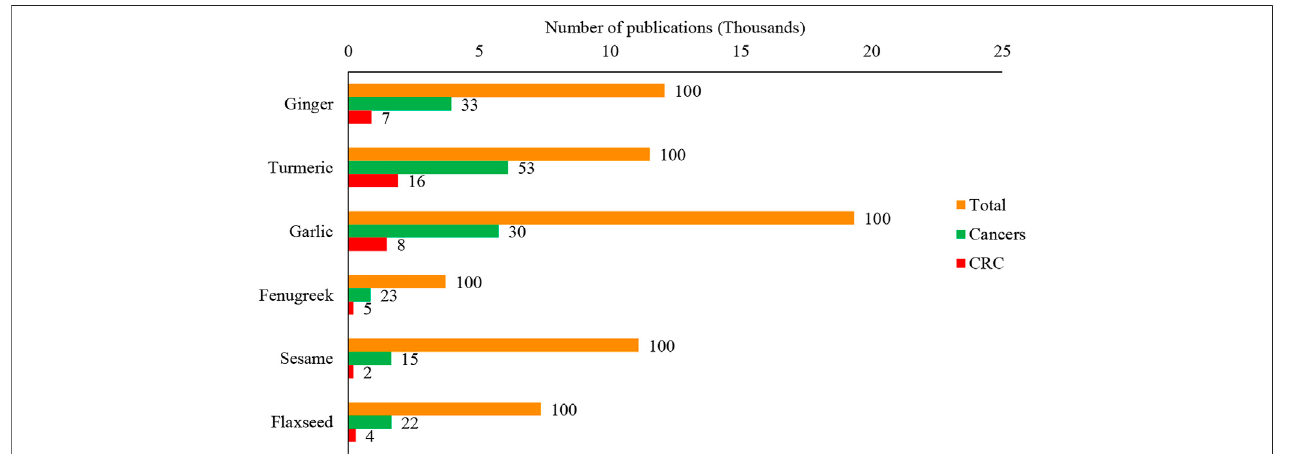
FIGURE1| Scienti fi cevaluationofculinaryspicesandherbsforthedifferentresearch,includingcancersandcolorectalcancer.Thevaluetoponthebarrepresents the per cent (%) value of the total publications of each plant. The data were retrieved from the Scopus database on 15 August 2021 using the search keywords: Ginger OR Zingiber of fi cinale Roscoe, Turmeric OR Curcuma longa L., Garlic OR Allium sativum L., Fenugreek OR Trigonella foenum-graecum L., Sesame OR Sesamum indicum L., Flaxseed OR Linum usitatissimum L., Cancer*, “ Colorectal cancer ” OR “ Colon cancer ” . CRC: Colorectal